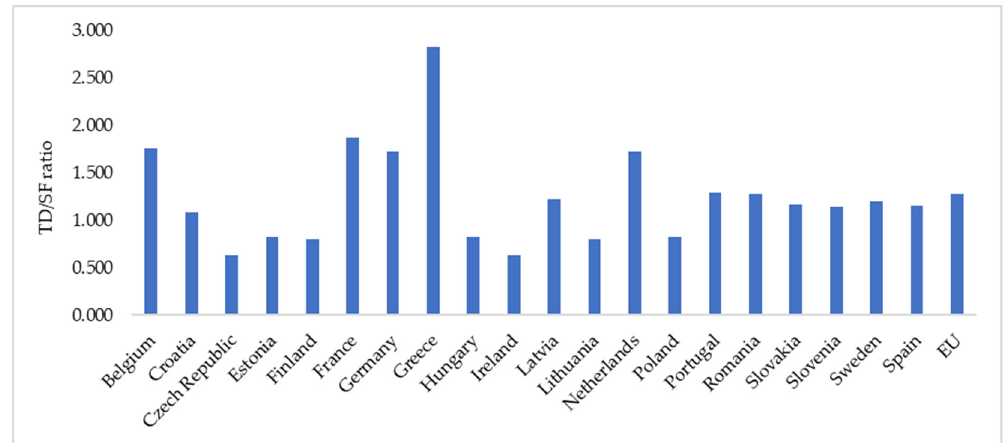
Figure 1. Solvency risk by country, full period—all risk categories. Source: authors’ calculations and representation